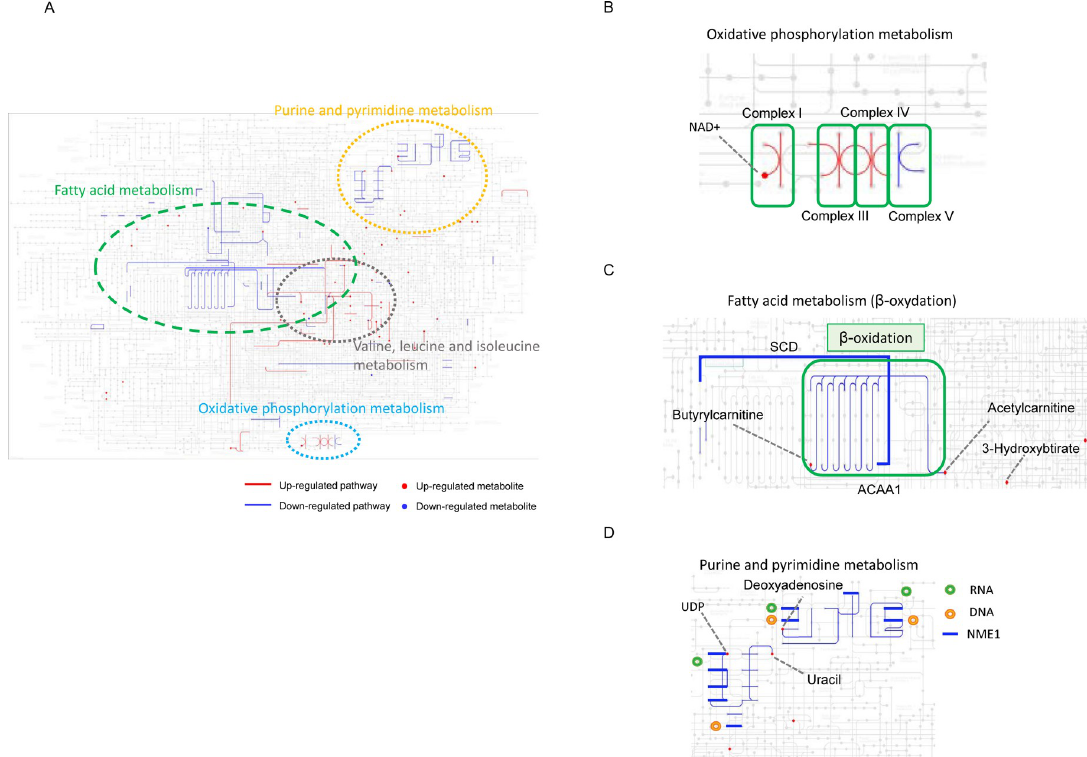
Fig 5. Metabolism map showing both CANA-altered metabolites and metabolic enzymes using multi-omics analysis of metabolomics and iMPAQT. Red line indicates an up-regulated pathway. Red circle indicates an up-regulated metabolite. Blue line indicates a down-regulated pathway. Blue circle indicates a down-regulated metabolite. A) Whole metabolism map. B) Map for oxidative phosphorylation metabolism. C) Map for fatty acid metabolism. Thick blue line indicates SCD pathway. Green rectangle indicates ACAA1 pathways. D) Map for purine and pyrimidine metabolism. Thick blue line indicates NME1 pathways. Abbreviations: NAD+, nicotinamide adenine dinucleotide; SCD, stearoyl-CoA desaturase; ACAA1, acetyl-coenzyme A acyltransferase 1; UDP, uridine diphosphate; RNA, ribonucleic acid; DNA, deoxyribonucleic acid; NME1, nucleoside diphosphate kinase1.